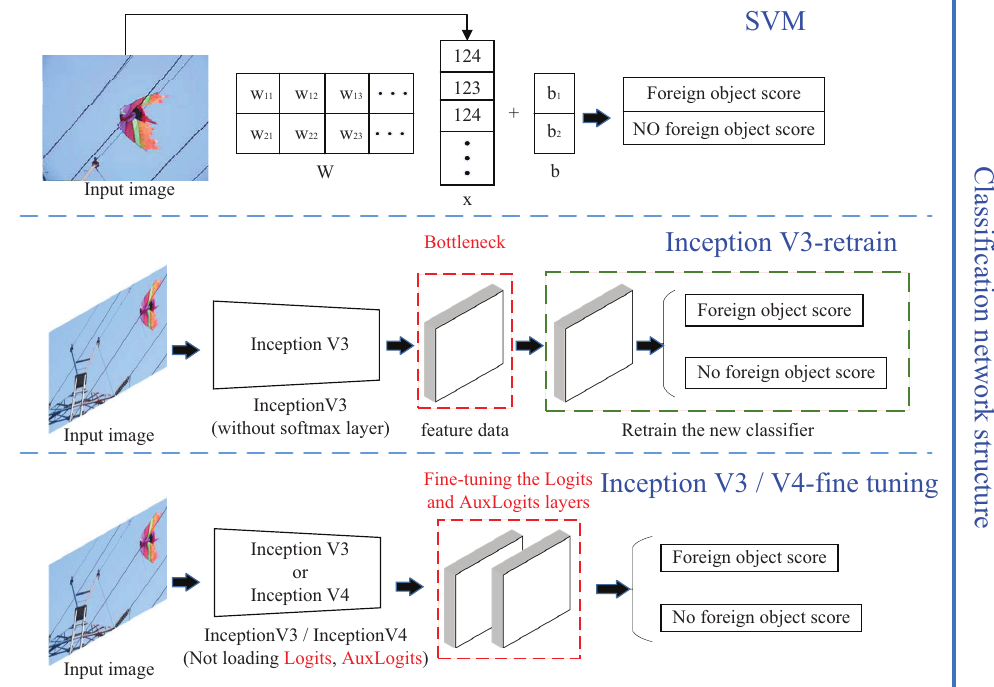
Figure 4. Classification network